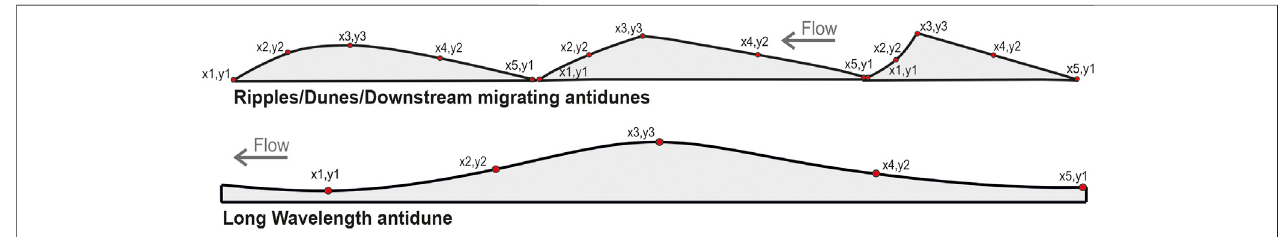
Frontiers in Earth Science |